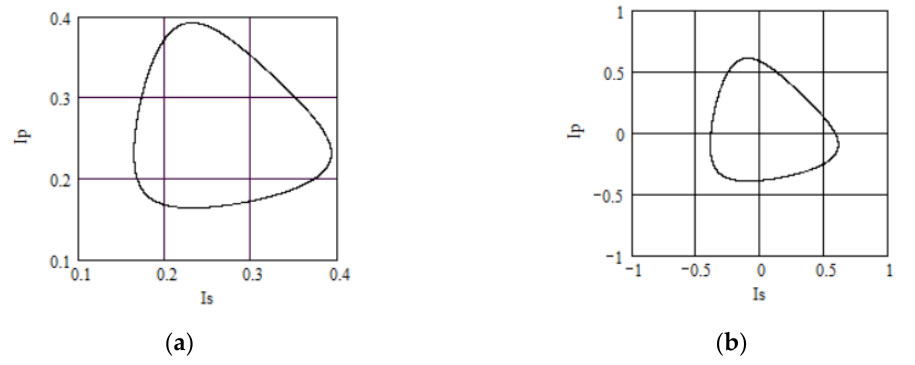
Figure 3. Orthogonal signal of polarized Fabry–Pérot interferometer. ( a ) Original signal; ( b ) signal with mean normalization processing.